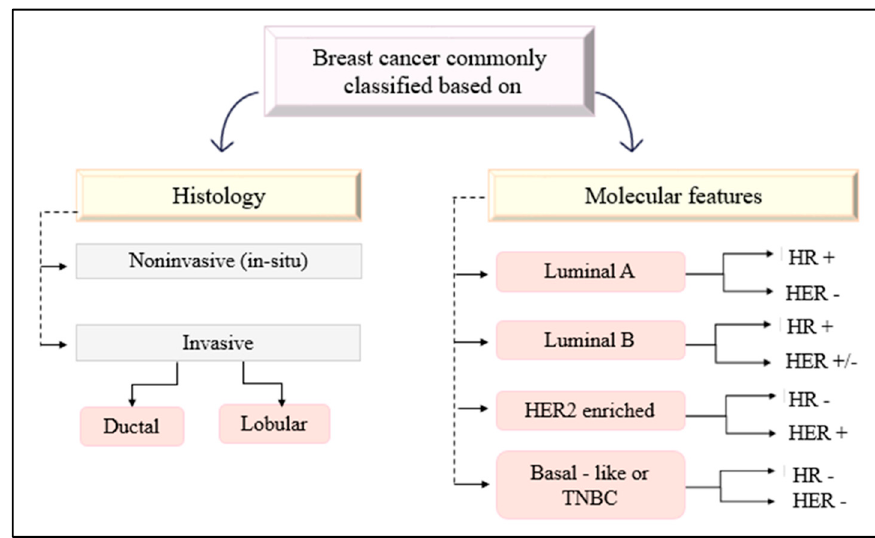
Figure 1. Classification of breast cancer based on histology and molecular features.